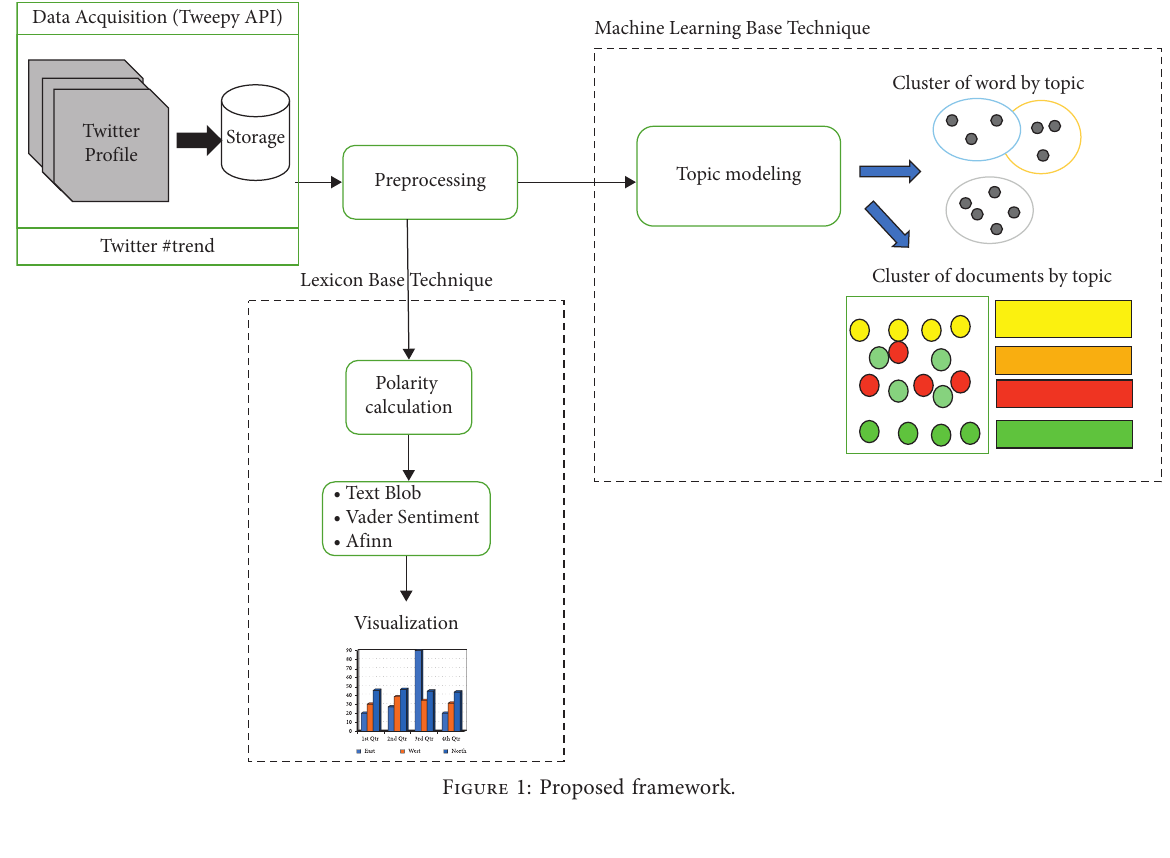
Figure 1: Proposed framework.